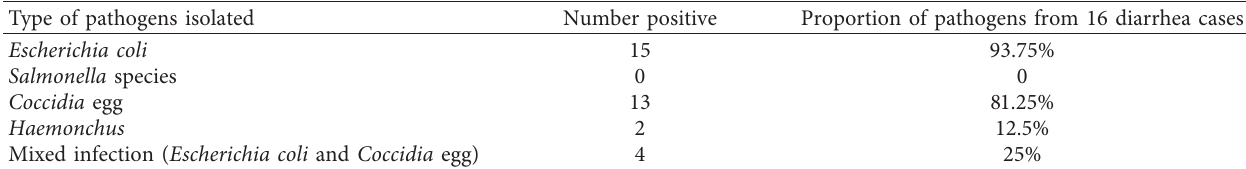
Table 4: Types of pathogens isolated from fecal samples of calf with diarrhea at Siyadeber and Wayu District, North Shewa, Amhara region, Ethiopia.